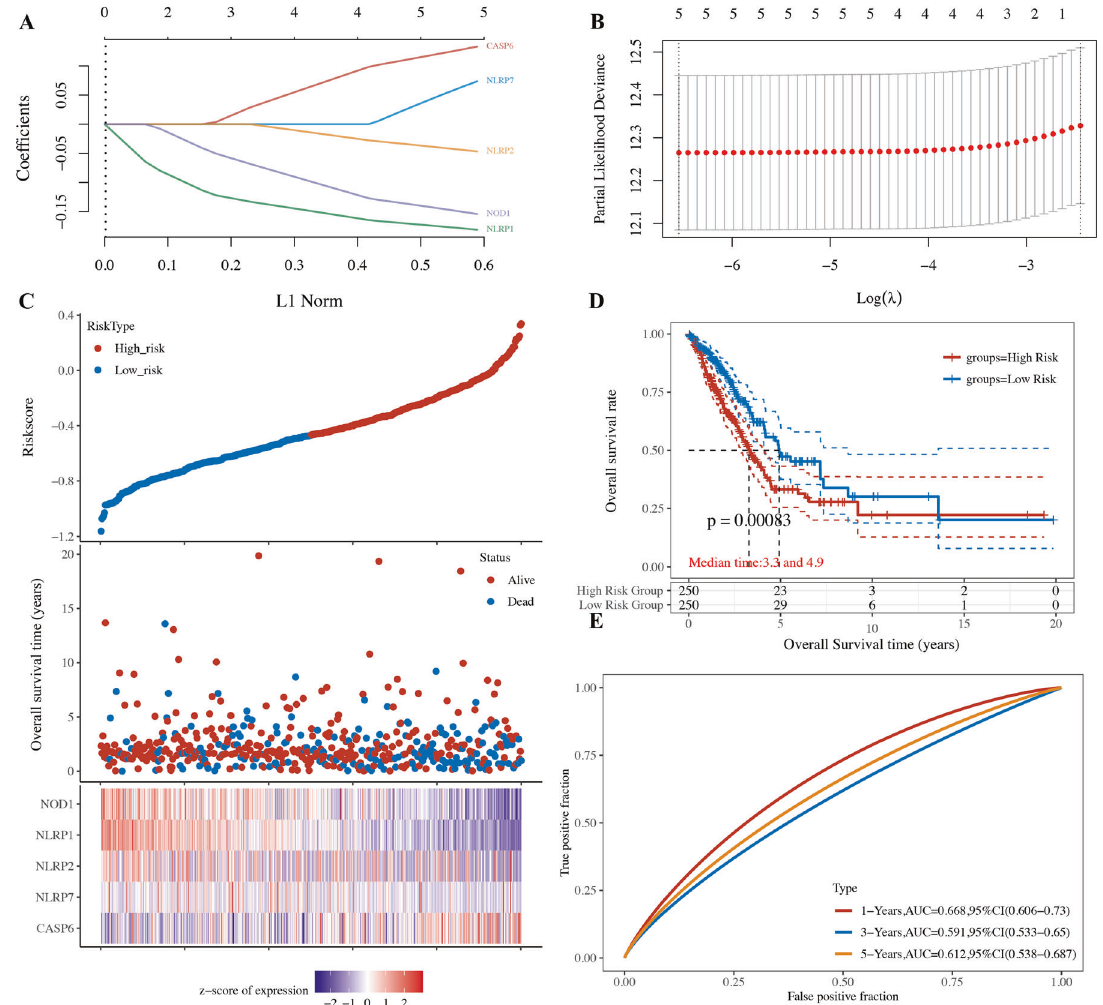
Fig. 4 Construction of a prognostic PRG model. A LASSO coef fi cient pro fi les of the fi ve PRGs. B Plots of the ten-fold cross-validation error rates. C Distribution of risk score, survival status, and the expression of fi ve prognostic PRGs in LUAD. D, E Overall survival curves for LUAD patients in the high-/low-risk group and the ROC curve of measuring the predictive value. PRG, pyroptosis ‑ related gene; LUAD, lung adenocarcinoma.